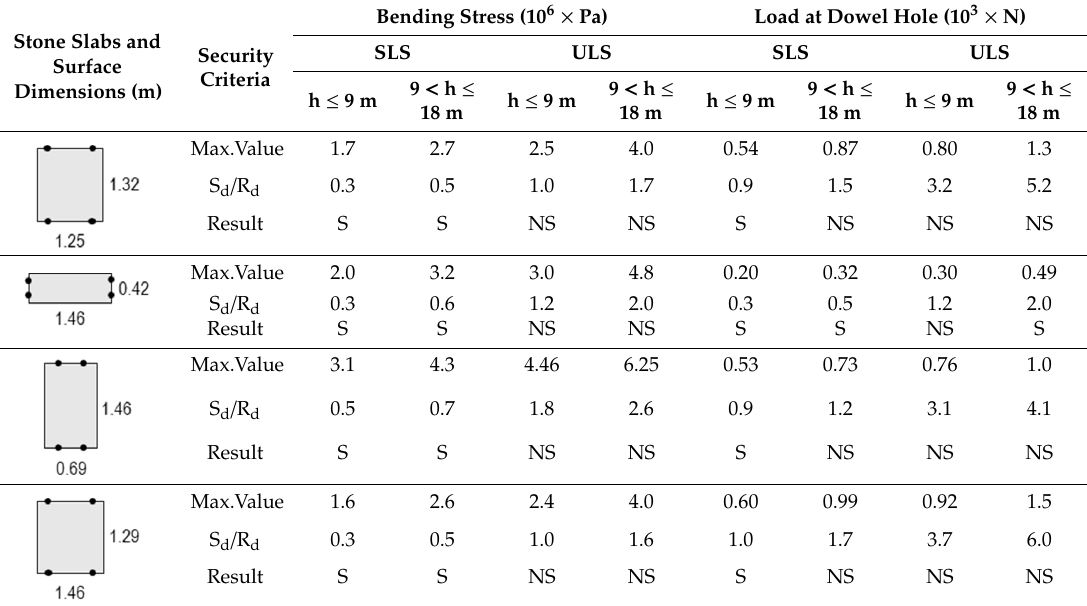
Table 2. Results obtained in FEM simulations and evaluation of stability. Stone Slabs and